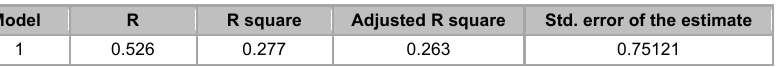
Summary for Model